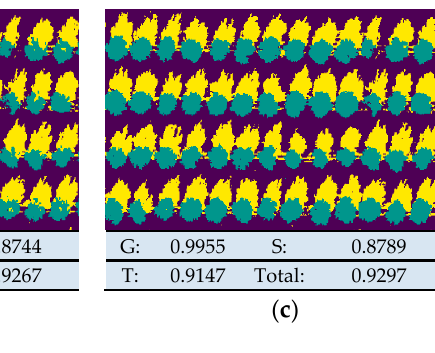
Table 3. The recognition accuracy of cross